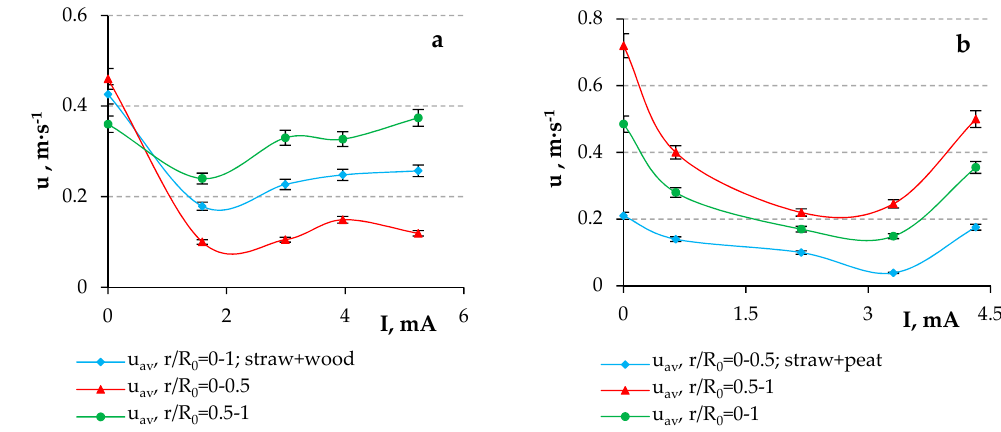
Figure 6. Electric field effect on the average values of the axial flow velocity component of the vortex flow forming in the combustion chamber at co-firing of straw with wood ( a ) or with peat ( b ).